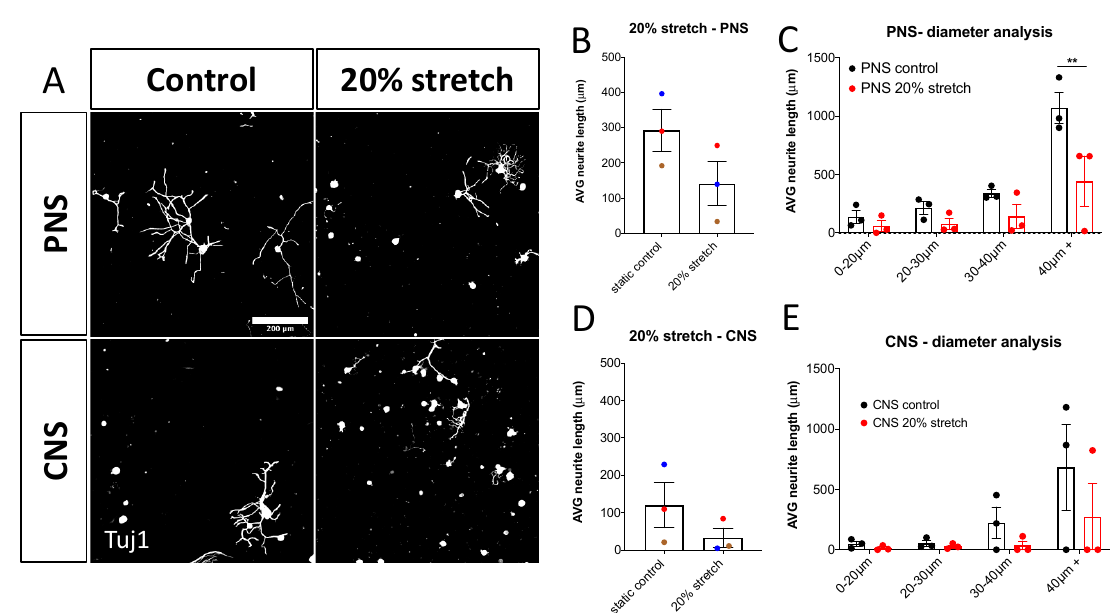
Figure 4. 20% 0.5 Hz stretch has a negative impact on neurite outgrowth of DRG in vitro. ( A ) Representative photomicro- graphs (10 × ) of cultured rat DRG following 20% 0.5 Hz stretch or no stretch and stained for β III-tubulin (Tuj1). Scale bar, 200 µ m. ( B ) Neurite length analysis of DRG cultured after 20% 0.5 Hz stretch of PNS-nerve explant compared to static control. Stretch appeared to have a negative impact on the neurite outgrowth, although not statistically significant. Paired two-tailed Student’s t-test, mean ± SEM of paired independent experiments indicated by the colors. ( C ) Diameter analysis showing a statistically significant reduction in the outgrowth of large-diameter neurons after a 20% stretch of the PNS- nerve explant. Two-way ANOVA with post-hoc Sidak’s multiple comparison test, mean ± SEM, ** p < 0.01, ( D ) Neurite length analysis of DRG cultured after 20% 0.5 Hz stretch of CNS-nerve explant compared to static control. Stretch appeared to have a negative impact on the neurite outgrowth of these cells as well, although not statistically significant due to high variability. Paired two-tailed Student’s t-test, mean ± SEM of paired independent experiments indicated by the colors. ( E ) Diameter analysis showing a reduction trend in the outgrowth of all DRG populations after 20% stretch of the CNS-nerve explant. Two-way ANOVA with post-hoc Sidak’s multiple comparison test, mean ± SEM, ** p < 0.01.